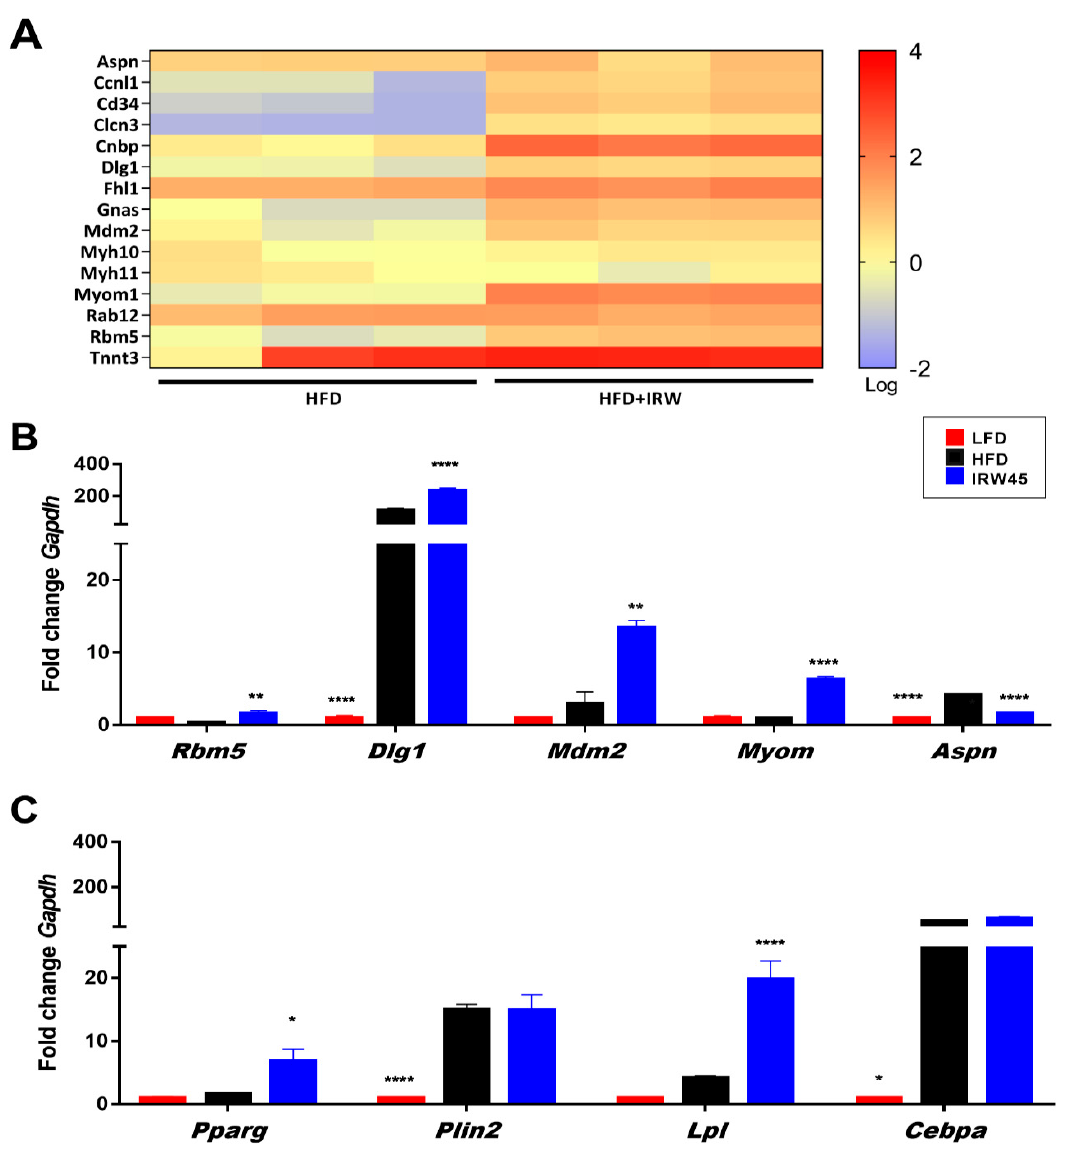
Figure 5. Skeletal muscle gene expression of mice fed IRW for 8 weeks. ( A ) Heatmap showing the abundance of major genes involved in muscle synthesis modulated by IRW45 determined by RNA sequencing. ( B ) Rbm5 , Mdm2 , Dlg1 , Myom1 , and Aspn qPCR validation of IRW in vivo using gastrocnemius skeletal muscle. Data expressed as mean ± SEM of n = 5 mice ( C ) Pparg, Plin2, Cebpa and Lpl qPCR validation using gastrocnemius skeletal muscle. Data expressed as mean ± SEM of n = 5 mice. Analysis by one-way ANOVA followed by Bonferroni’s post-hoc comparison test or Kruskal–Wallis followed by Dunn’s post hoc test when appropriate. * p < 0.05, ** p < 0.01, and **** p < 0.0001 versus HFD.